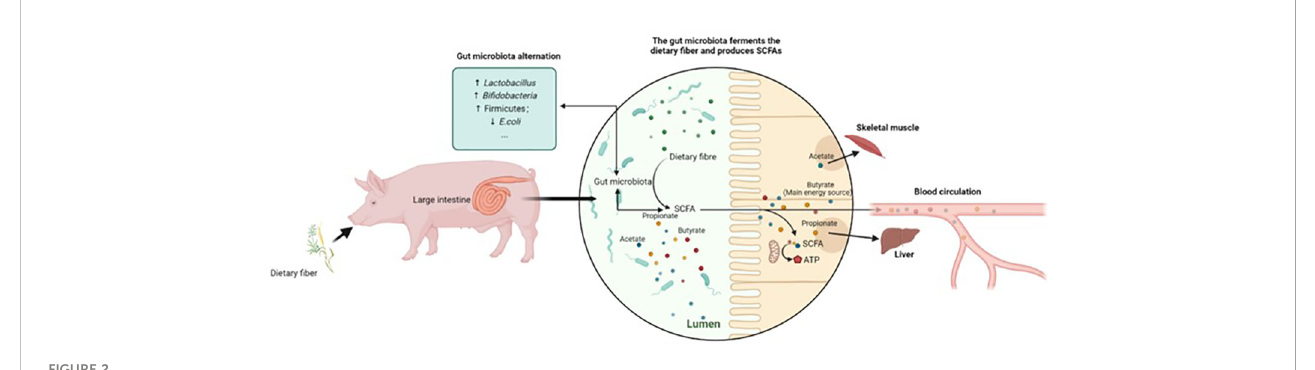
FIGURE 2 An example of gut microbiota alteration facilitated by the microbial fermentation of